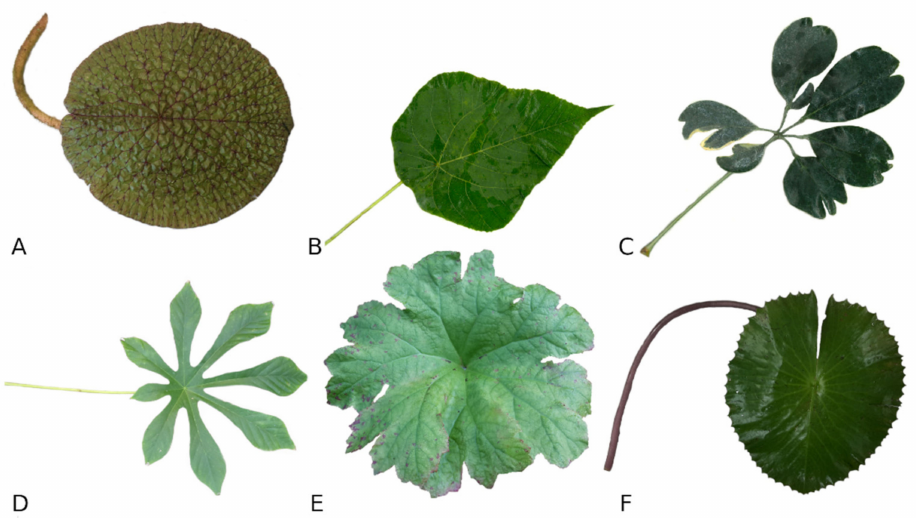
Figure 1. Variety of peltate leaf shapes (according to Troll, 1932 and Ebel, 1998 [18,20]). ( A )—orbicular entire ( Euryale ferox ), ( B )—ovate entire with pointed apex ( Macaranga tanarius ), ( C )—palmately compound with leaflets ( Schefflera arboricola ), ( D )—palmatipartite ( Cecropia peltata ), ( E )—palmatifid ( Darmera peltata ), ( F )—orbicular crenate toothed ( Nymphaea lotus ). ( A , E )—central petiole insertion, ( B – D , F )—eccentric insertion of